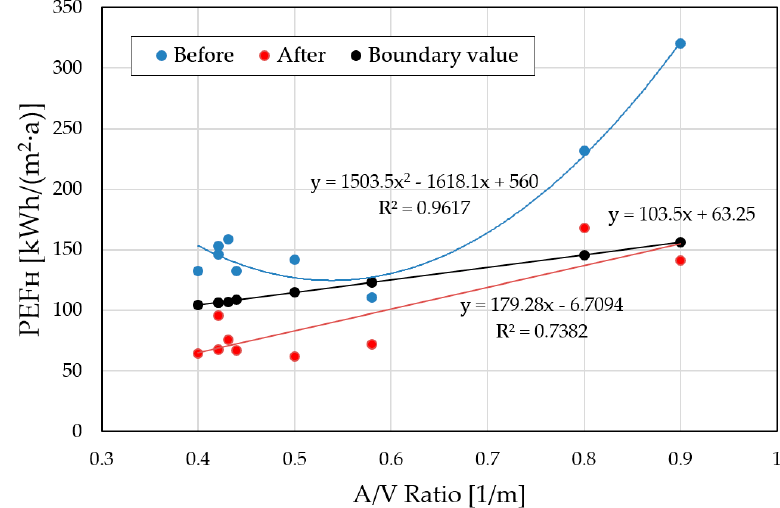
Figure 3. Relation between Primary Energy Factor for Heating evaluated by measurements and A/V ratio of all tested buildings, before and after retrofitting.